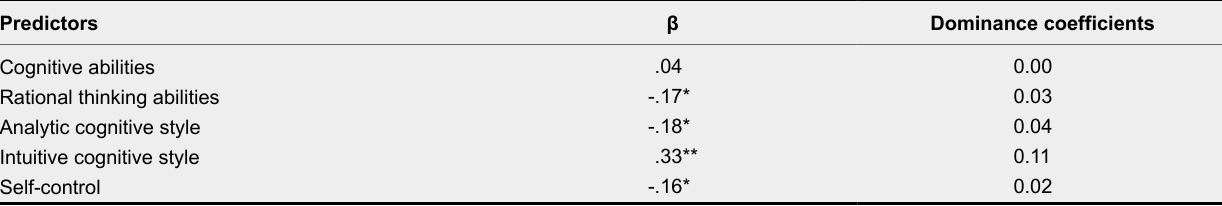
Regression Analysis With Cognitive Abilities, Rational Thinking Abilities, Analytic Cognitive Style, Intuitive Cognitive Style and Self-Control as Predictors, and Epistemically Suspect Beliefs Score as an Outcome Predictors β Cognitive